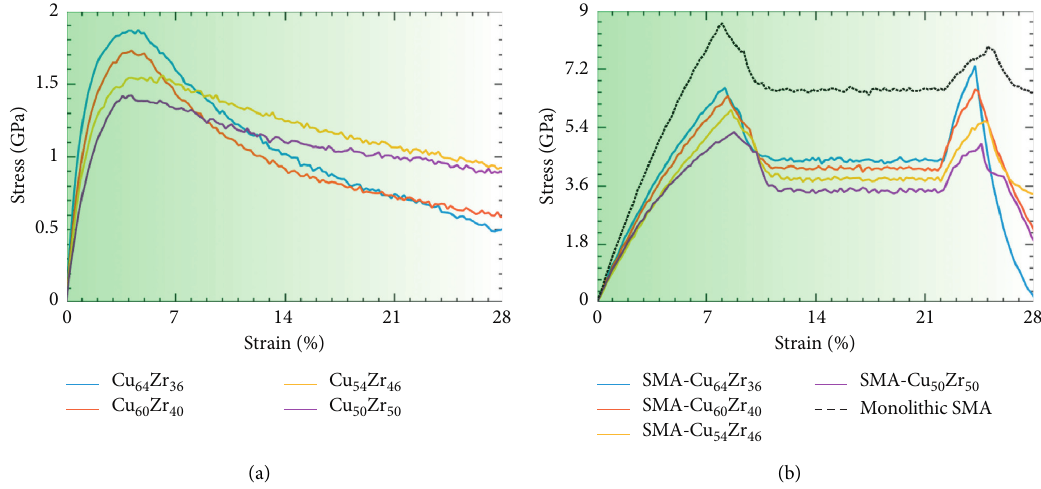
Figure 2: Stress-strain curves of (a) monolithic MGs and (b) monolithic SMA and the